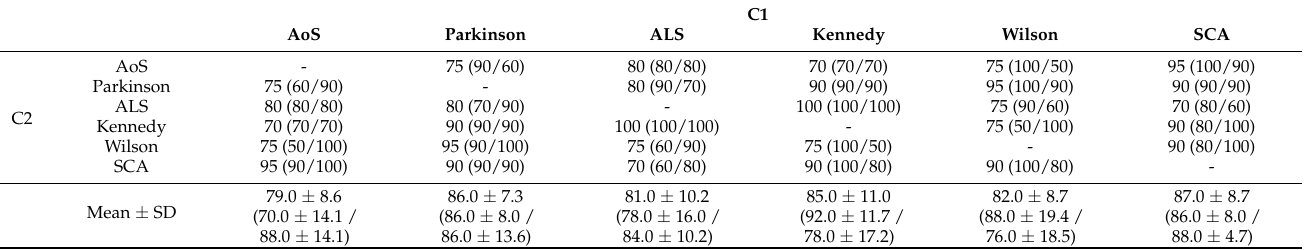
Table 2. Classification accuracy (i.e., percentage of correctly classified patients) for all considered two-class classifications. The first entry inside the parentheses corresponds to the percentage of correctly classified patients from class C1. The second entry inside the parentheses corresponds to the percentage of correctly classified patients from class